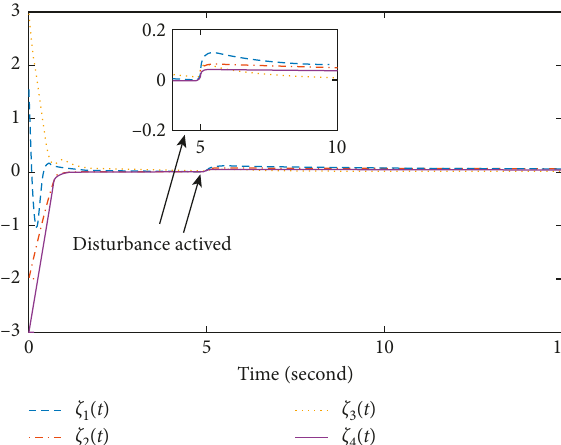
Figure 5: Time response of state variables.